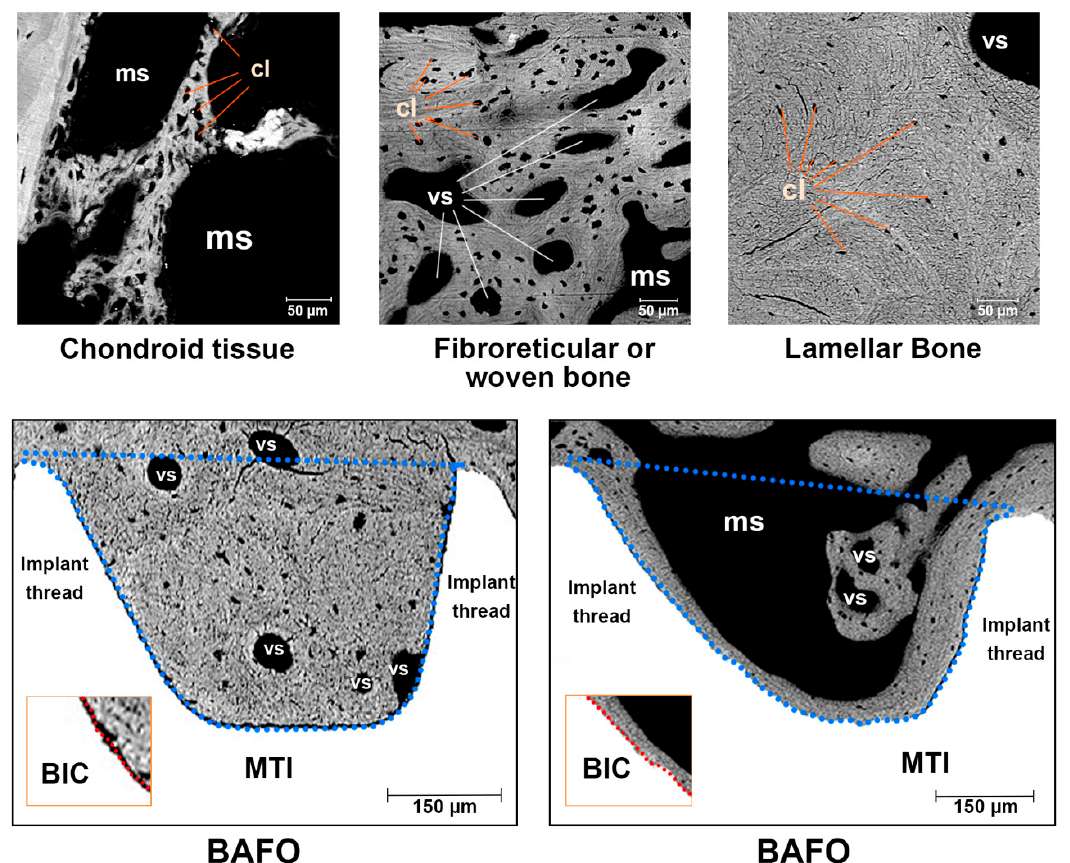
Figure 2. In the upper part, the types of bone tissue studied in the samples are shown; in the lower part, the bone area fraction occupancy (BAFO) used as an analysis unit in this study is shown (delimited by the blue broken line between two implant threads). Samples of Bone to Implant Contact (BIC) area are shown in the boxes inside the inferior images. cl = cellular lacunae; ms = medullar space; vs = vascular space; MTI = mini transitional implant (surface).